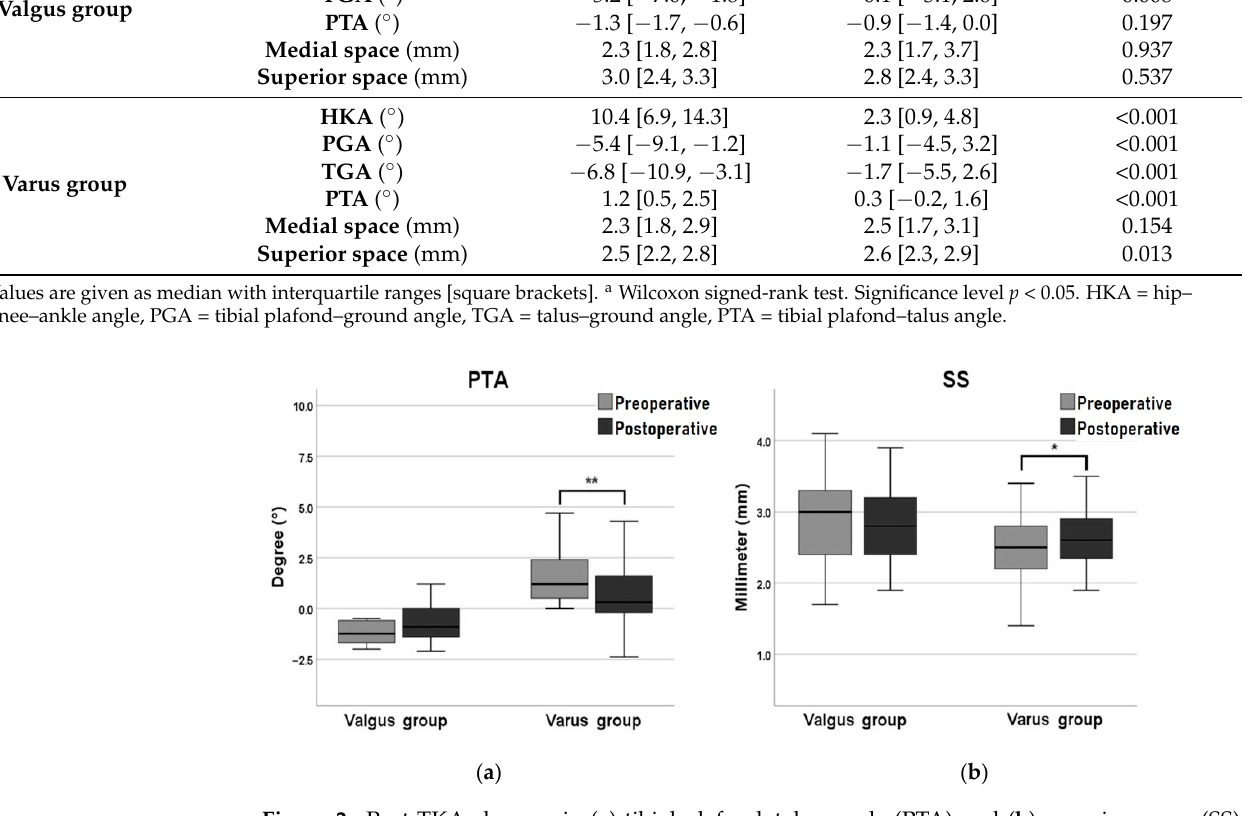
Table 3. Correlation between ankle parameter changes and HKA changes as well as preoperative HKA.